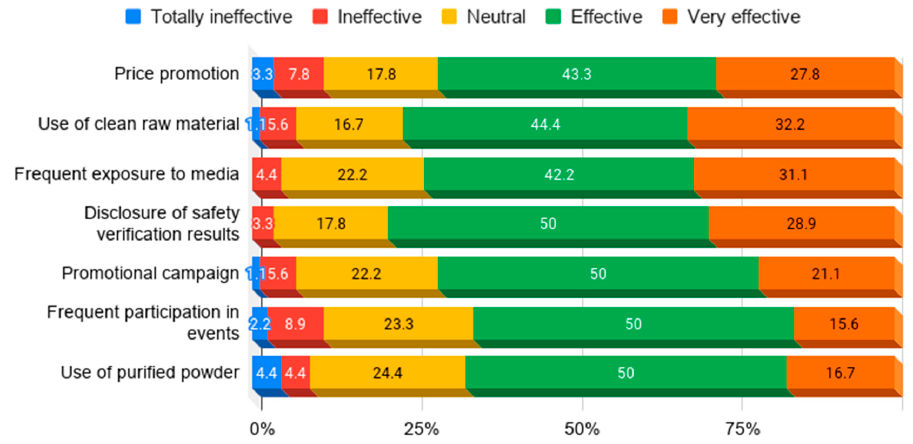
Figure 4. E ffi ciency of promotion strategies for insect medical foods. Figure 4. Efficiency of promotion strategies for insect medical foods.